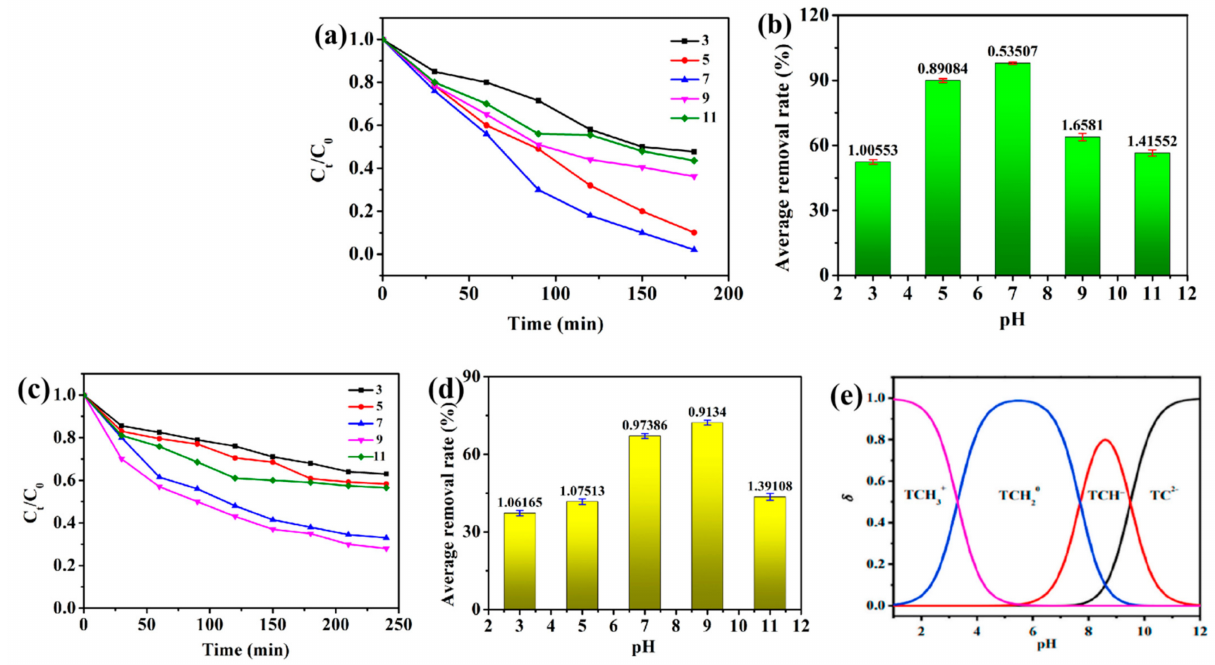
Figure 6. ( a ) Effect of catalyst 1 on TC degradation at different pH conditions. ( b ) Average re- moval rate of catalyst 1 to TC. ( c ) Effect of catalyst 2 on TC degradation at different pH conditions. ( d ) Average removal rate of catalyst 2 to TC. ( e ) The existence of tetracycline at different